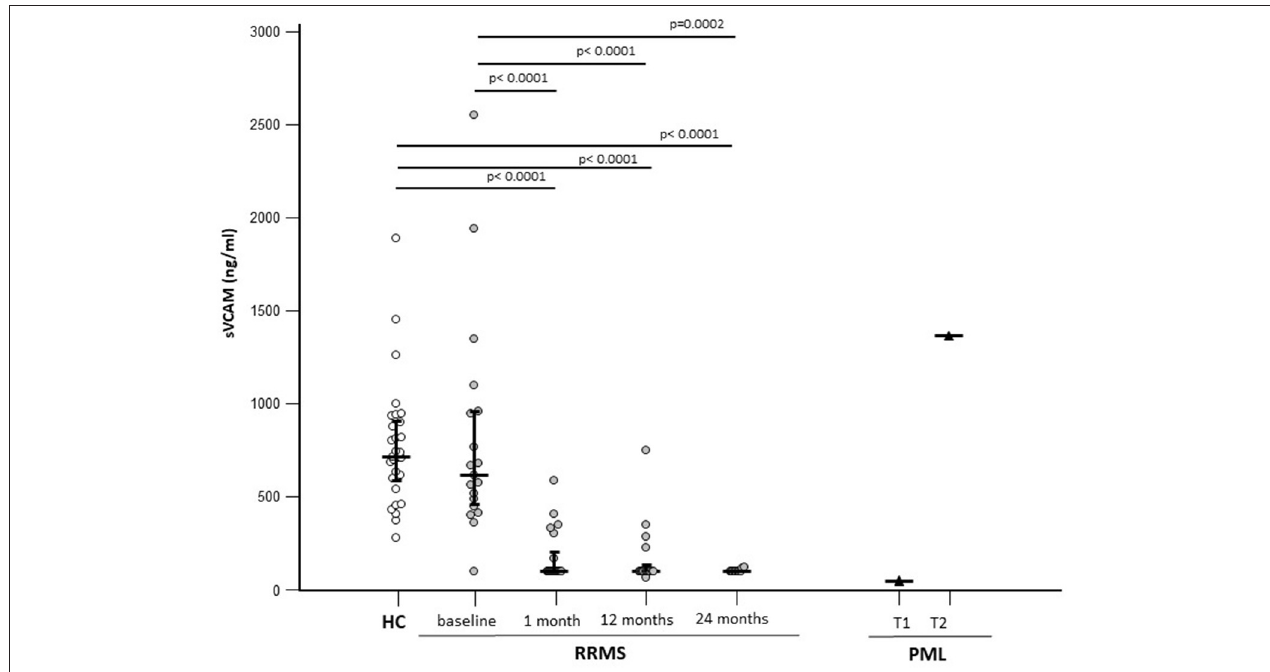
FIGURE 3 | Serum sVCAM-1 concentrations in patients with a diagnosis of RRMS ( N = 22) or PML ( N = 1) and in age-and sex-matched HCs ( N = 29). Results before (baseline) and at 3 different time points are initiation of NTZ therapy are shown. For the patients with PML time at PML diagnosis (T1) and 12 months after PML diagnosis (T2) are shown. The expression of miR-126-3p (copies/ng) is presented as median and IQR. Statistical significances are